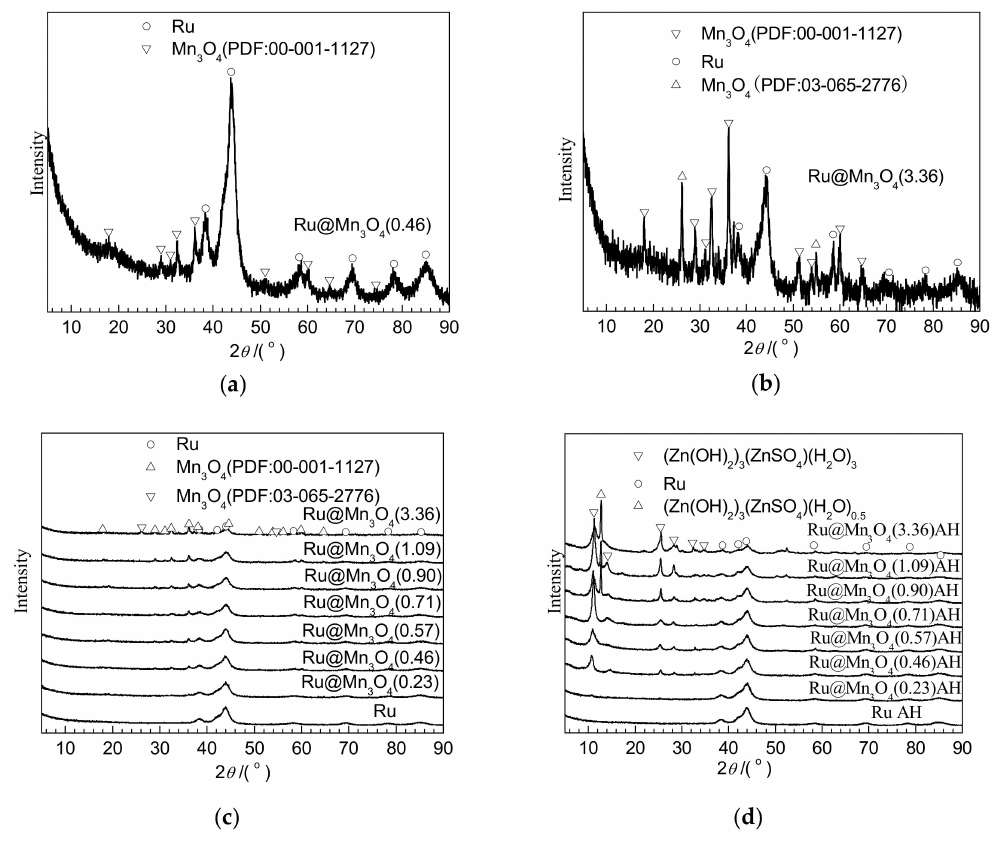
Figure 1. XRD patterns of Ru@Mn 3 O 4 (x) before ( a – c ) and after ( d ) catalytic experiments. AH means after hydrogenation